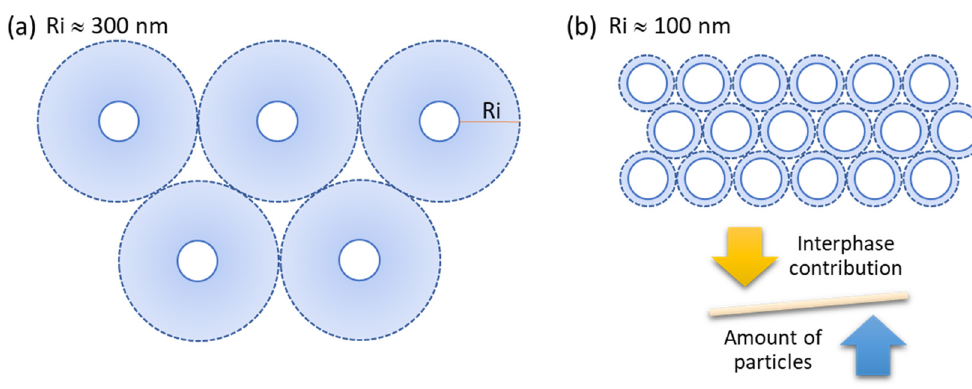
Figure 12. Schematic representation of particles and interphases for two different thicknesses (Ri): ( a ) Ri ≈ 300 nm and ( b ) Ri ≈ 100 nm values like those estimated for PSF + 1% HA and PSF+ 10% HA, respectively.